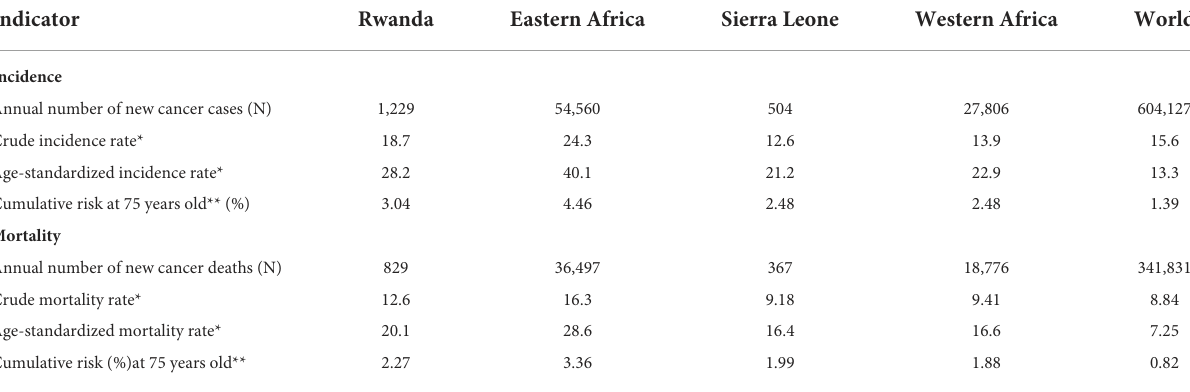
TABLE 3 Cervical cancer incidence and mortality in Rwanda, Sierra Leone, sub-Saharan Africa, and worldwide estimates for 2020. Indicator